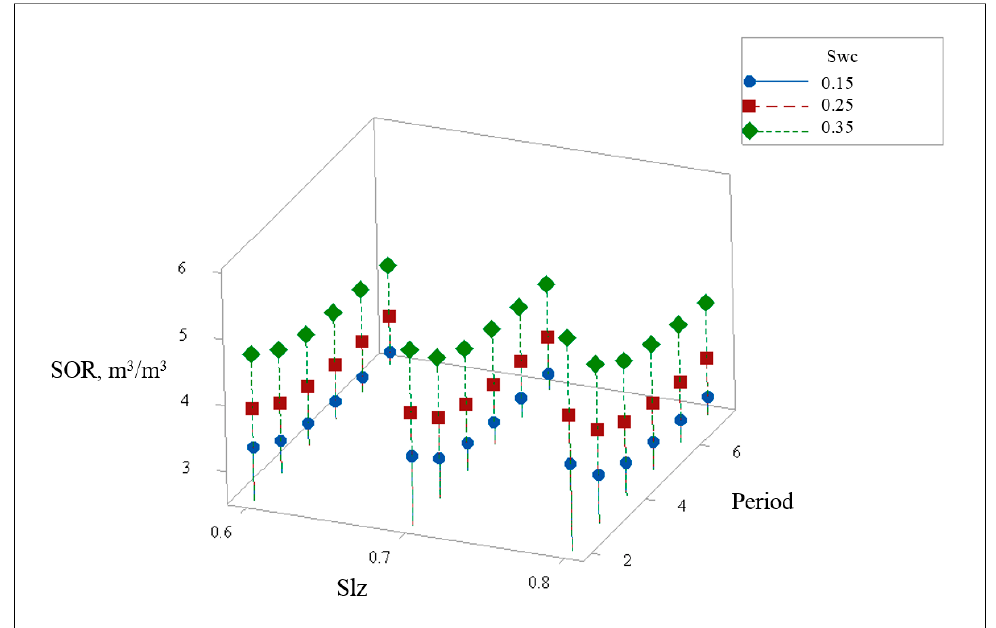
Figure 5. Relationship between width, interval distance, thickness, and SOR.